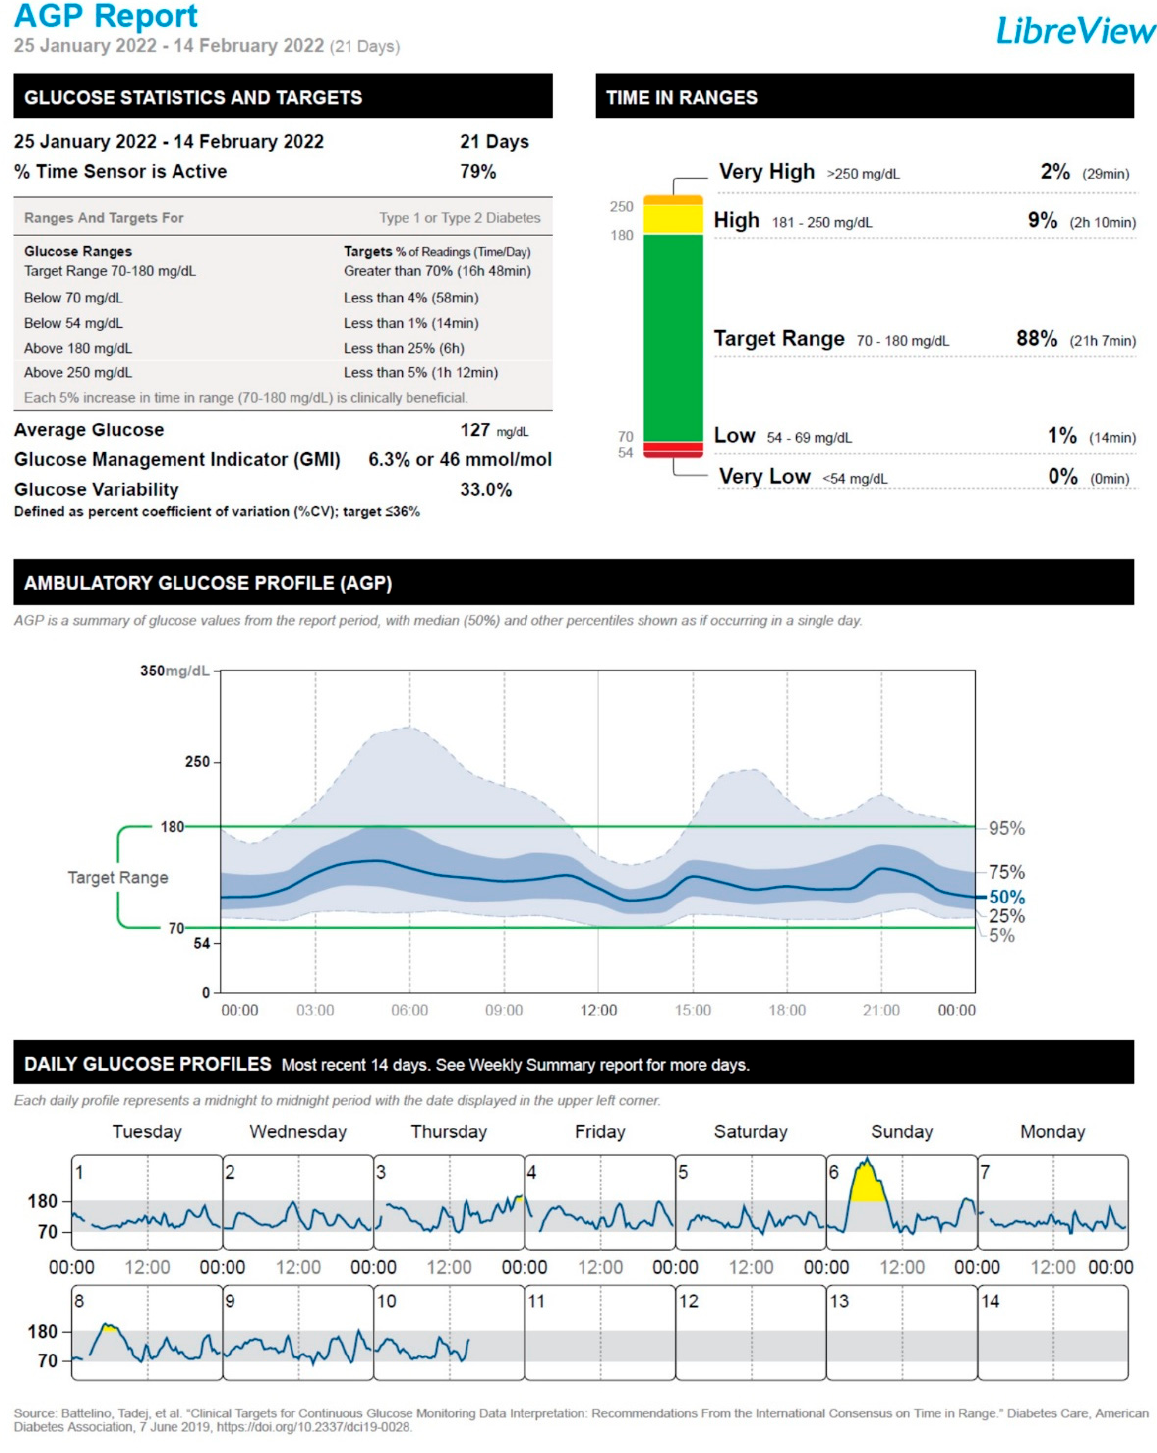
Figure 4. Ambulatory glucose profile (AGP) obtained from the subcutaneous glucose sensor referring to the 21-day period: 25 January 2022 through 14 February 2022.